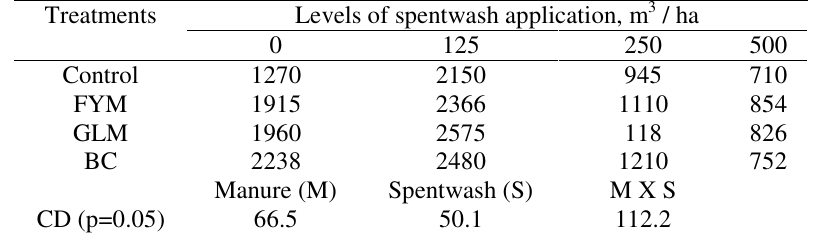
Table 2. Effect of spentwash with and without organic amendments on grain yield of rice (kg/ha)(s) Treatments